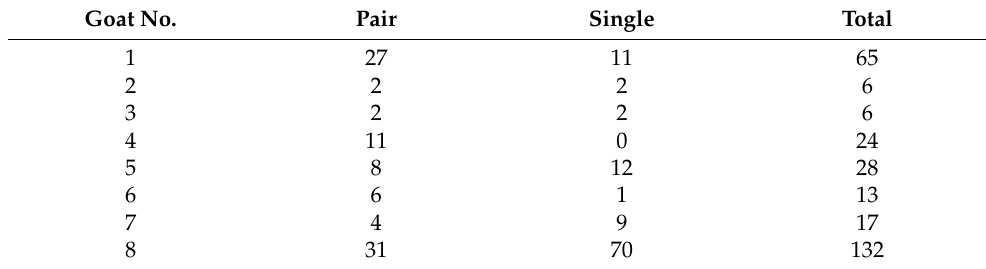
Table 4. The worm burden of each infected goat. Goat No.